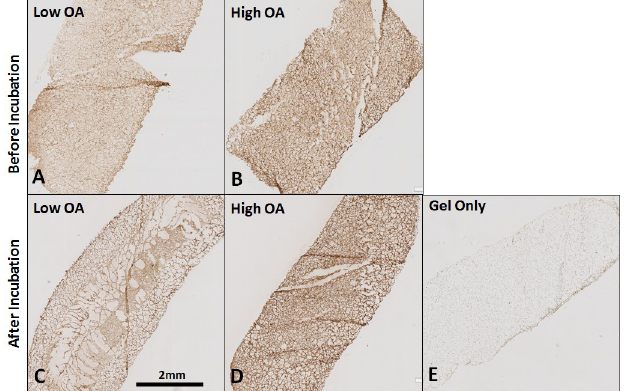
Fig 2. Representative sections of gels before ( A , B ) and after 5 days ( B - E )in vitro incubationshowedOA was detected in gels in both low OA ( A , C ) and high OA ( B , D ) groupswhile no OA in gel only group ( E ) Before and after incubation, the amount of OA in the high OA group ( B , D ) appearedhigherthan that in the low OA group ( A , C ). The amount of OA in each low or high OA group after incubationappearedto be similar in the gels before incubation.Scale bar = 2 mm appliesto all